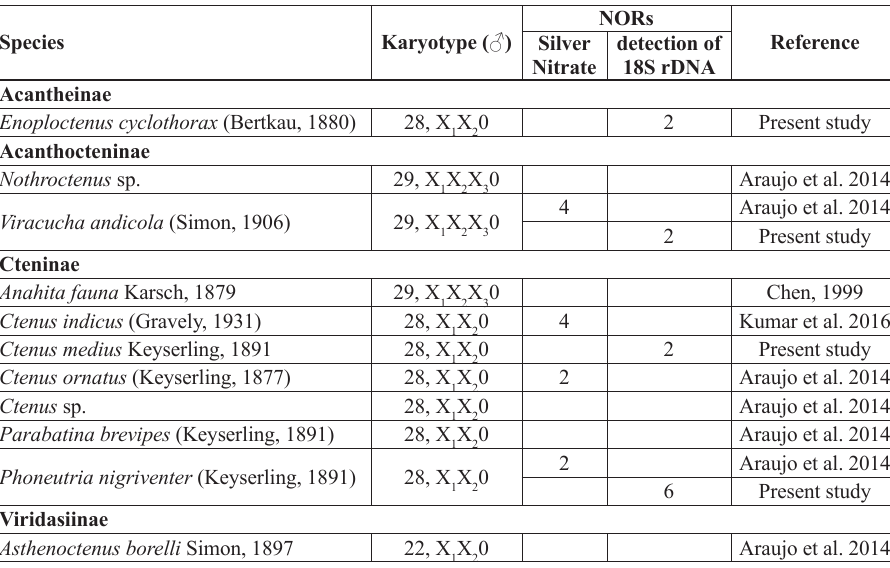
Table 1. Cytogenetic data of Ctenidae species, updated from Araujo et al. (2014), including the data of present study. NOR = nucleolus organizer